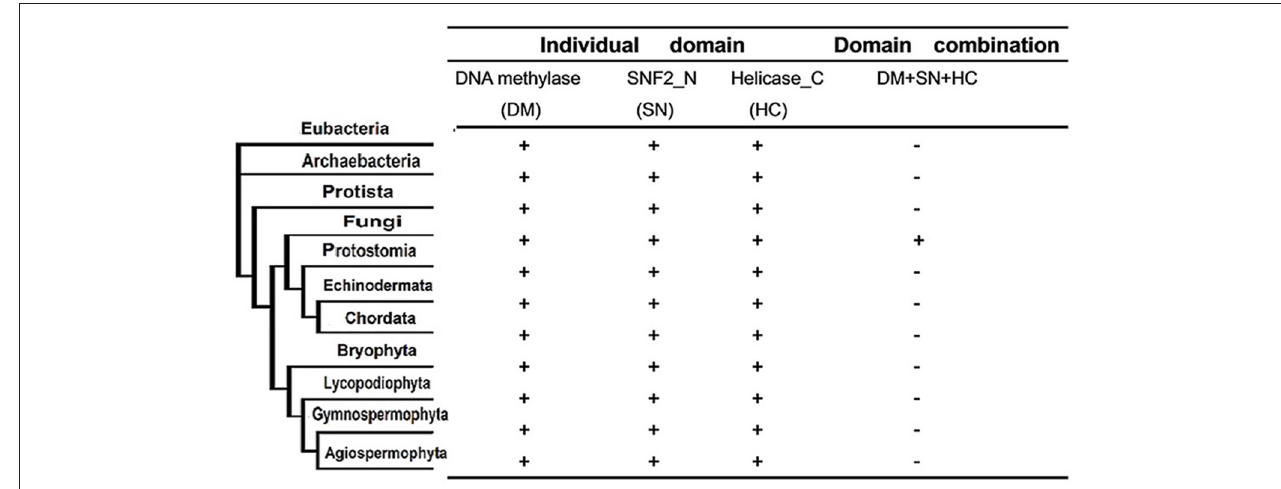
FIGURE 3 | Phyletic distribution of taxonomic organisms and domain fusion event of characteristic domains between DNMtase family and Snf2 family identified in a genome-wide survey of representative species. The distribution and domain fusion event were mapped to the phyletic tree. Plus ( + ) and minus ( − ) indicate the domain presence/absence in the corresponding phylogenetic clade under the cut-off of e < 10 − 4 in the hmmpfam toolset.